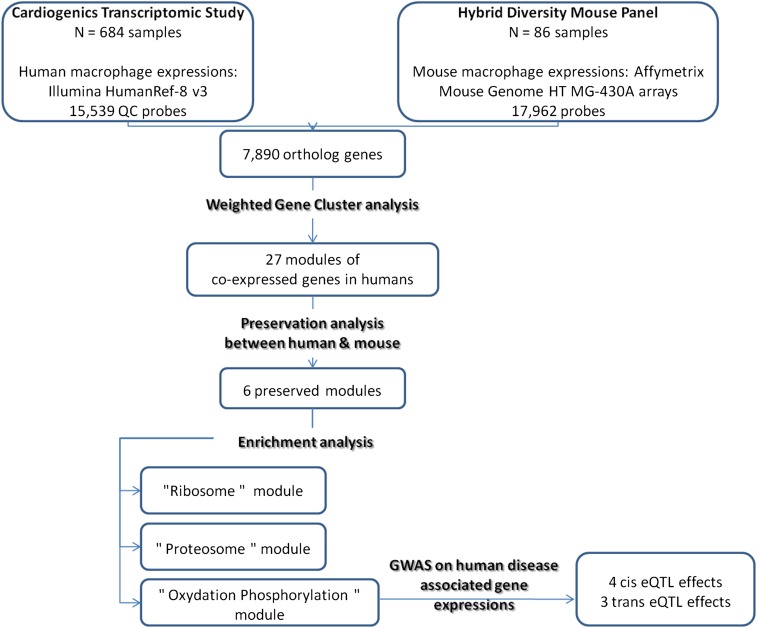
Analysis workflow of the present study.